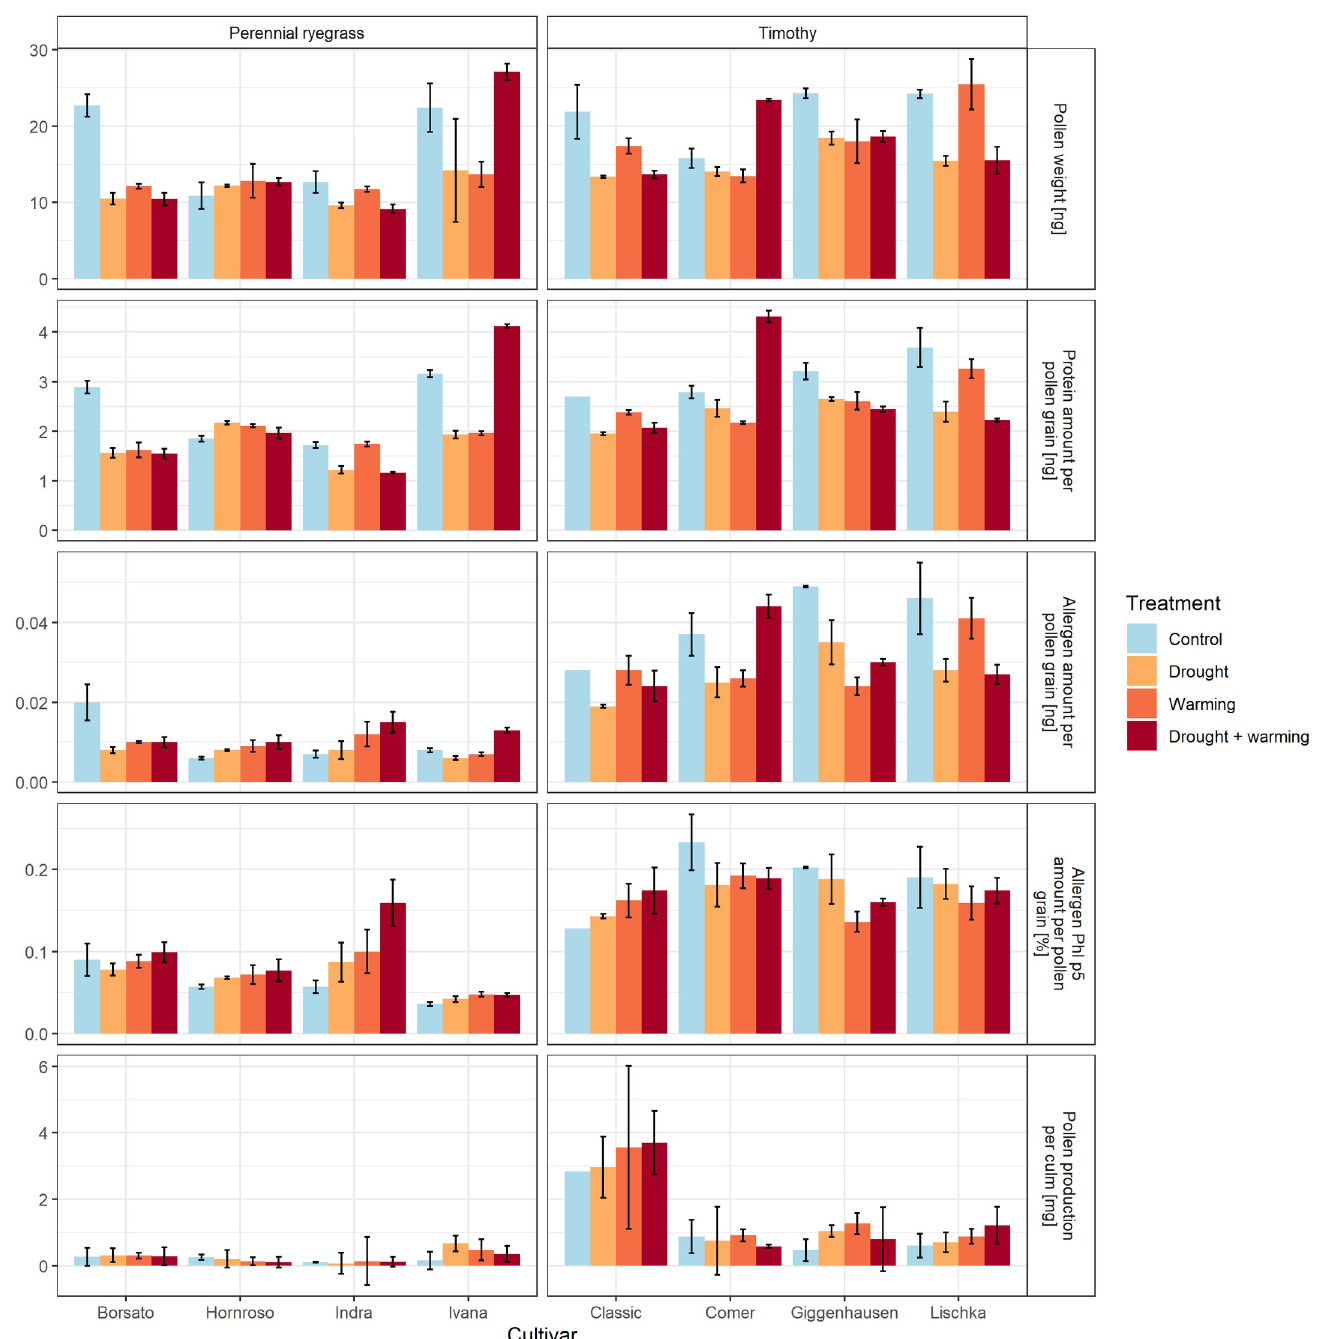
Fig 5. Pollen characteristics, top to bottom: Pollen weight per pollen grain in [ng], protein amount per pollen grain [ng], allergen amount per pollen grain [ng], allergen Phl p5 amount per pollen grain [%] and pollen production per culm [mg] for perennial ryegrass and timothy. Colors represent the treatments; error bars indicate the standard error of three repetitions (due to lack of material, Classic control was not repeated except for pollen weight).